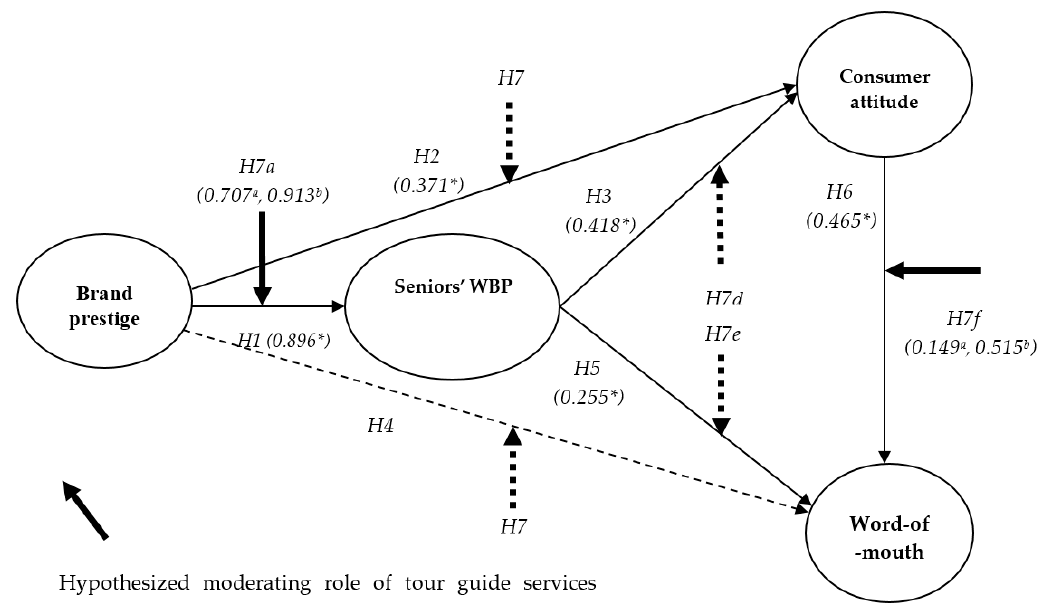
Figure 2. Structural model results.